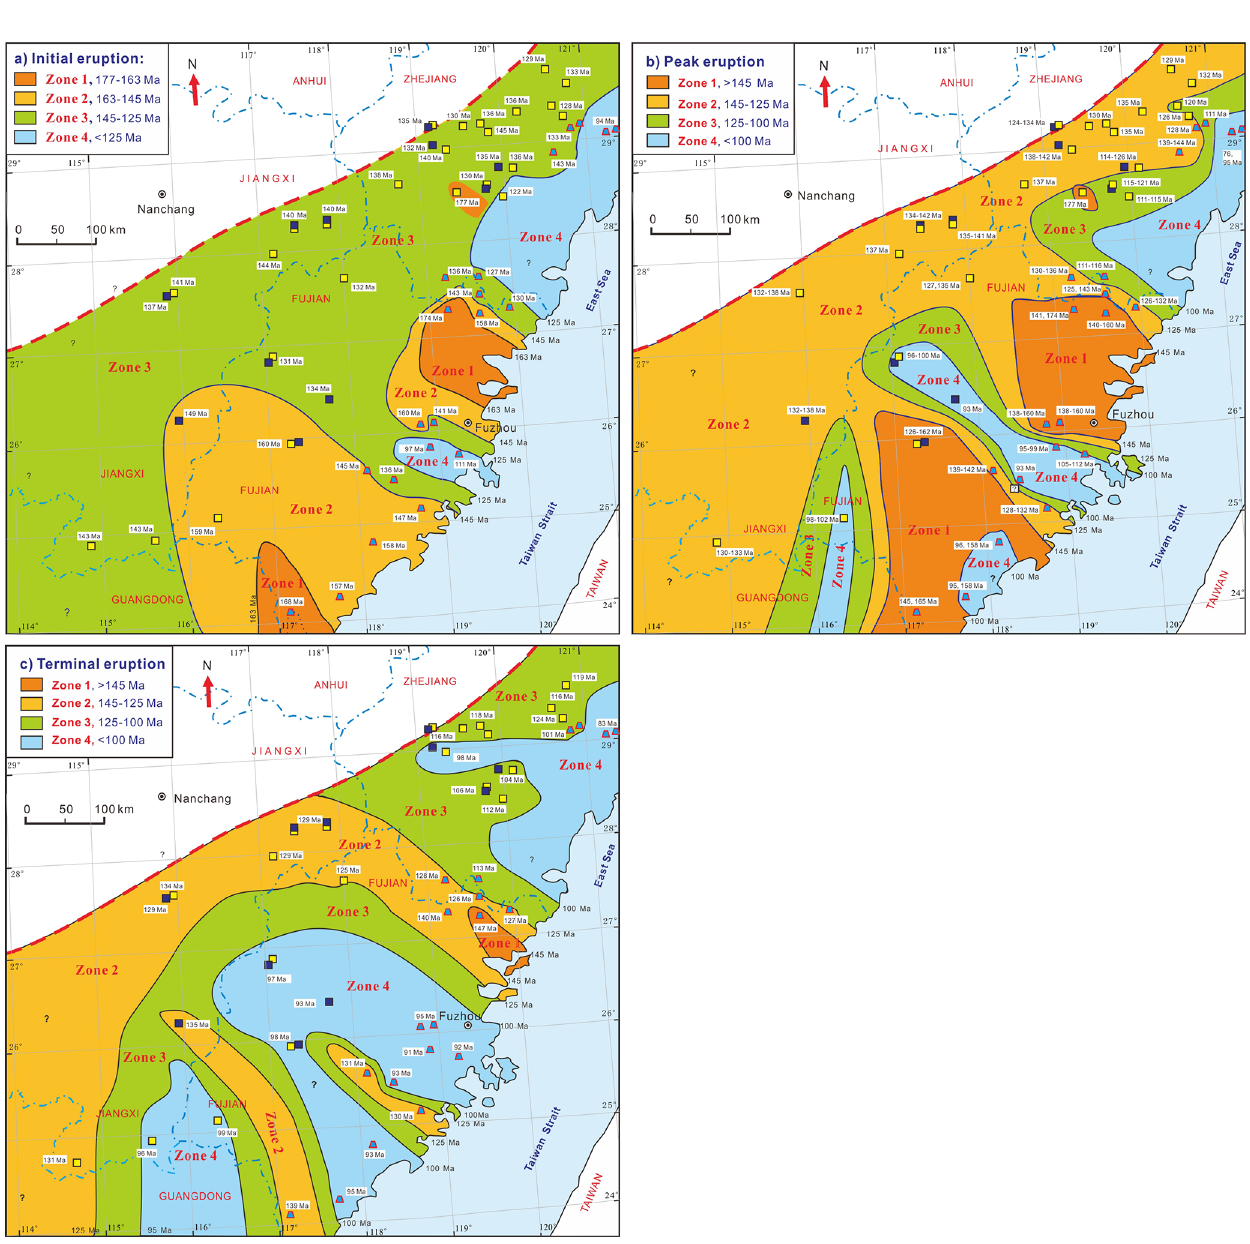
Figure 5. Sketch maps showing zonations of the late Mesozoic volcanism by age in SE China (map modified from Shu et al., 2009). Age within white rectangles is the eruption time at a location or in a basin or region. Names of color squares and trapezoids refer to Fig. 1. (a) Zonations of initial eruption ages; (b) zonations of peak eruption ages; (c) zonations of terminal eruption